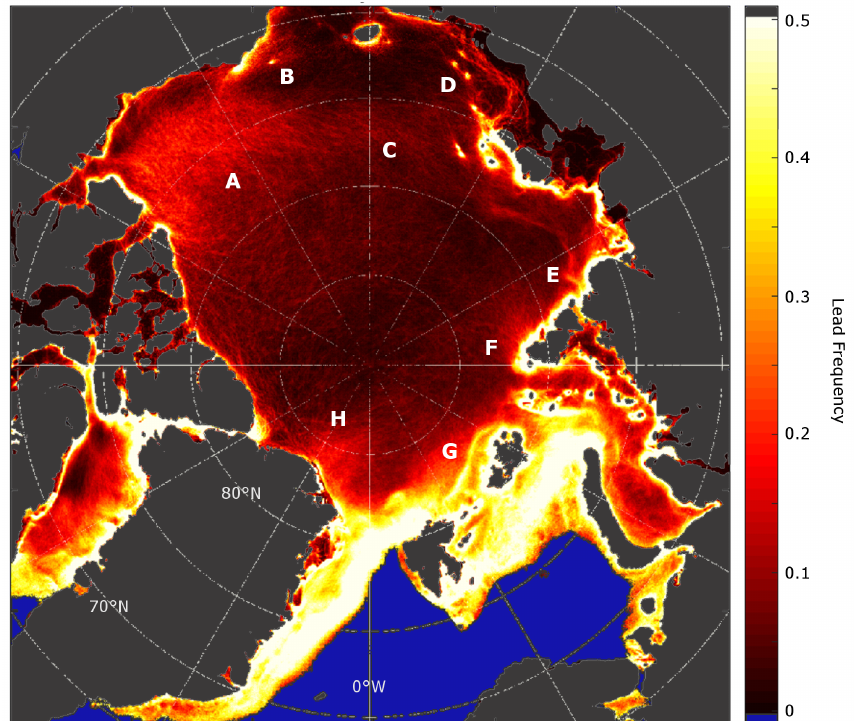
Figure 5. Average pan-Arctic lead frequencies from daily FCAF filtered lead maps, January to April, 2003–2015. A cut-off value of 0.5 is applied to highlight patterns in the value range 0 to 0.5. Highlighted regions: A = Beaufort Sea, B = Hanna Shoal, C = Band between the Beaufort Sea and New Siberian Islands, D = two unknown lead hot spots in the East Siberian Sea, E = Vilkitsky canyon outflow region, F = fracture zone east of Severnaya Semlya, G = Elongated region with high lead frequency northwest of Franz Josef Land and H = enhanced lead activity north of